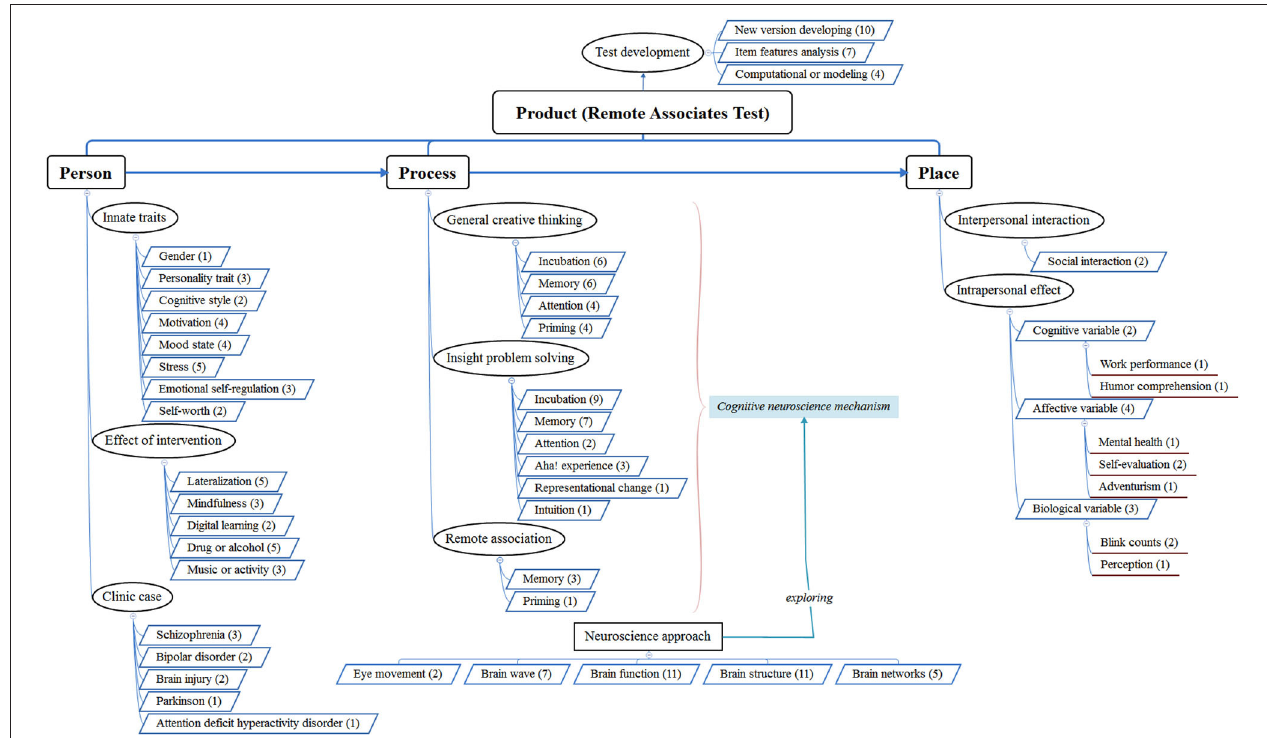
FIGURE 1 | The framework of the remote associates test applied to the 4P creativity model. Only some subcategories of each category are presented.